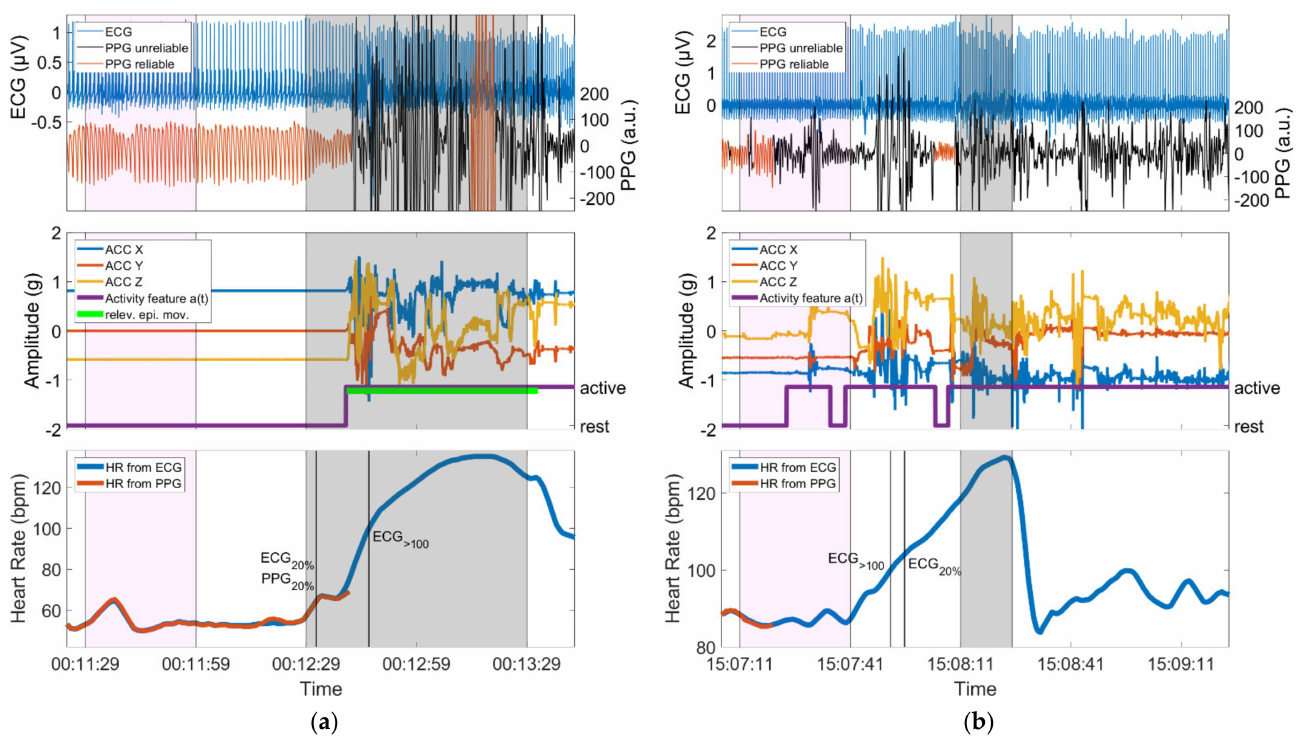
Figure 8. ( a ) Seizure with motor automatisms (relev. epi. mov.) performed with the left arm during the ictal phase; the device is worn on the left wrist. The identification of PPG 20% occurs before the initial arm automatisms and is in very good temporal agreement with ECG 20% , whereas PPG >100 is not identified, as ECG >100 is only crossed during the phase of epileptic movements; ( b ) Seizure with almost continuous spontaneous movements during the baseline period, the preictal, ictal and postictal phase. Identification of IT is not possible due to the spontaneous movements. In both panels, the baseline period and the ictal phase are highlighted in magenta and gray, respectively. Vertical lines mark the timing of identification of threshold crossings. Both panels show data from a period of 140